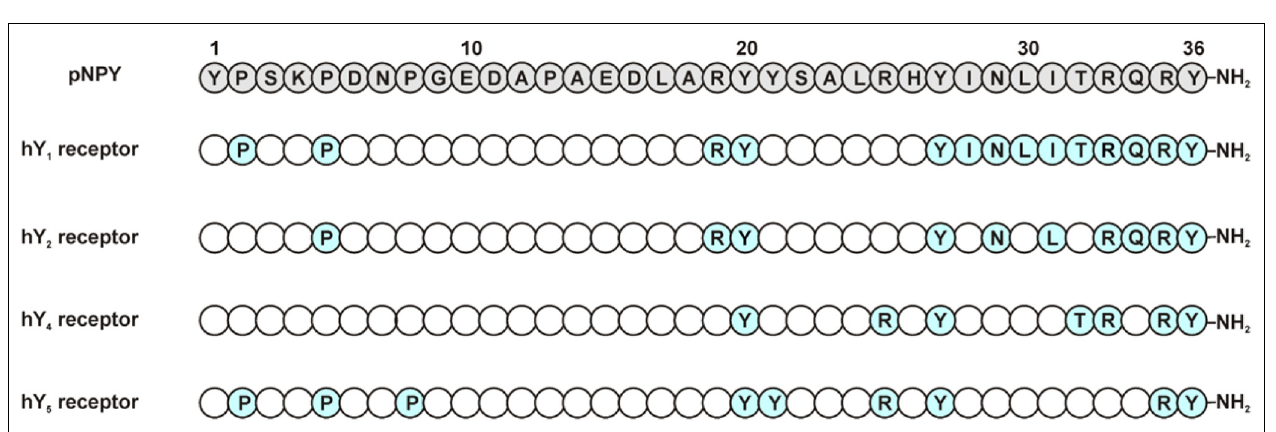
FIGURE 2 | Peptidic antagonists of theY 1 receptor (Parker etal., 1998; Koglin etal., 2003).